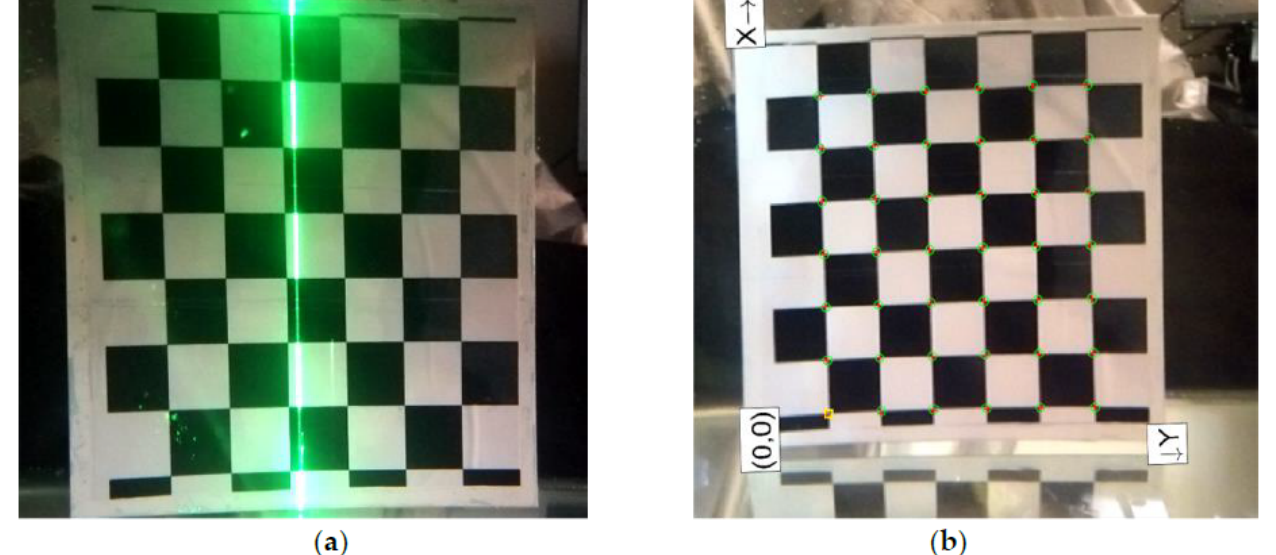
Figure 8. Underwater chessboard calibration. ( a ) Checkerboard calibration; ( b ) Corner extraction of underwater chessboard.